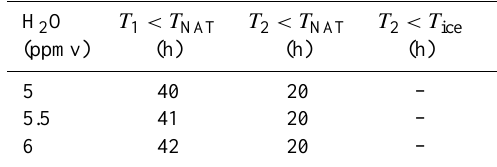
Table 1. Time periods when T 1 and T 2 were below the NAT and ice threshold temperature along the back trajectory. T NAT and T ice were derived for H 2 O mixing ratios of 5, 5.5. and 6ppmv for the trajectory started on 26 February 2011 at 00:00UTC (Case 1). Only increases in water vapour were